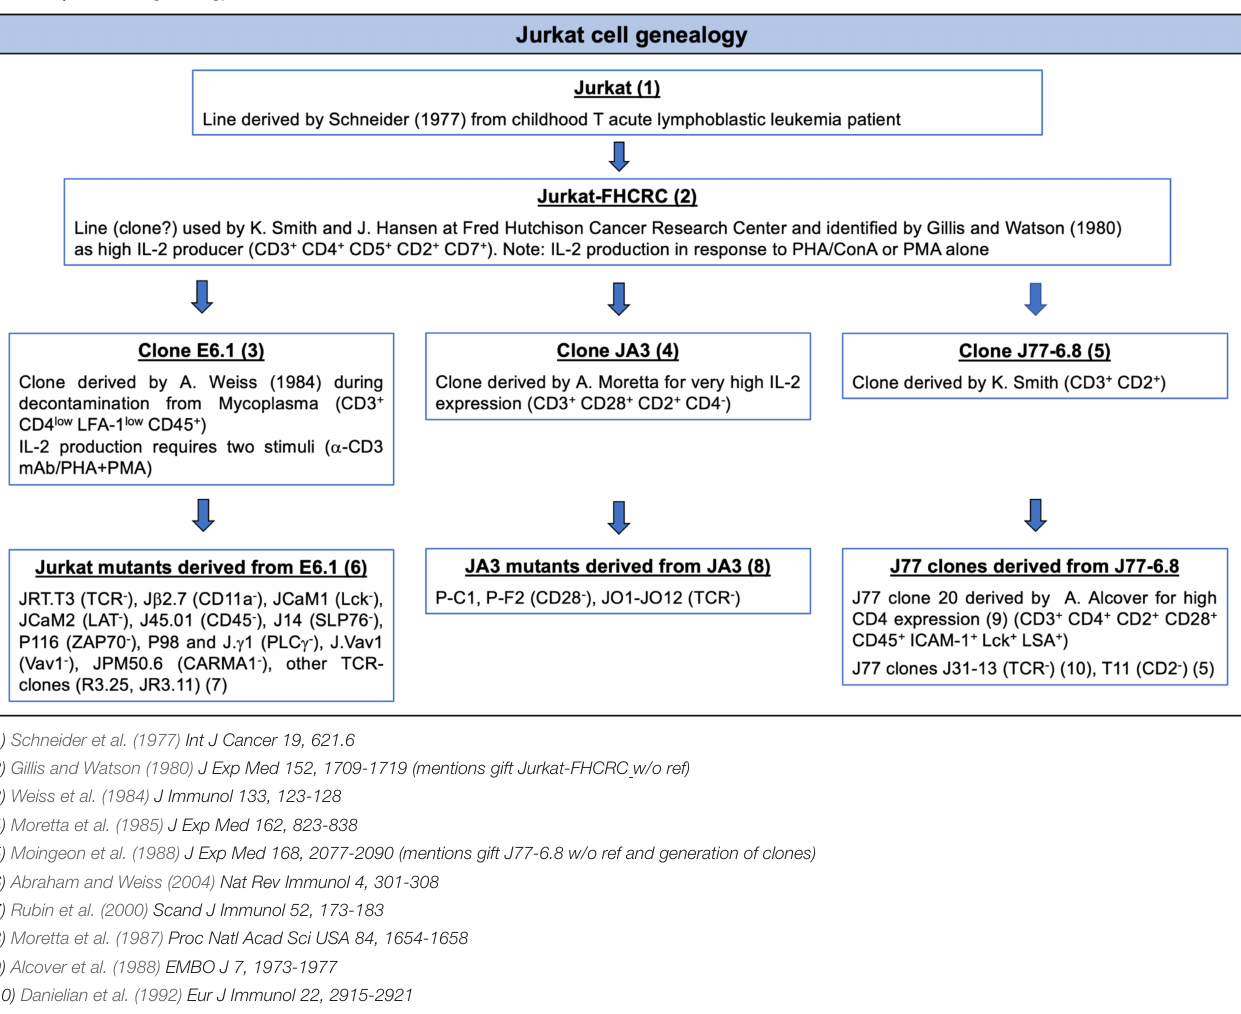
TABLE 1 | Jurkat cell